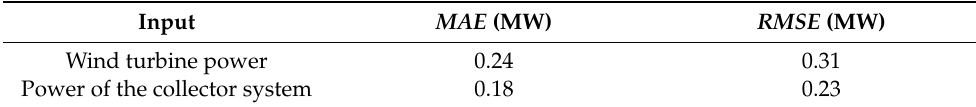
Table 1. Error comparison of submarine cable loss calculation results.